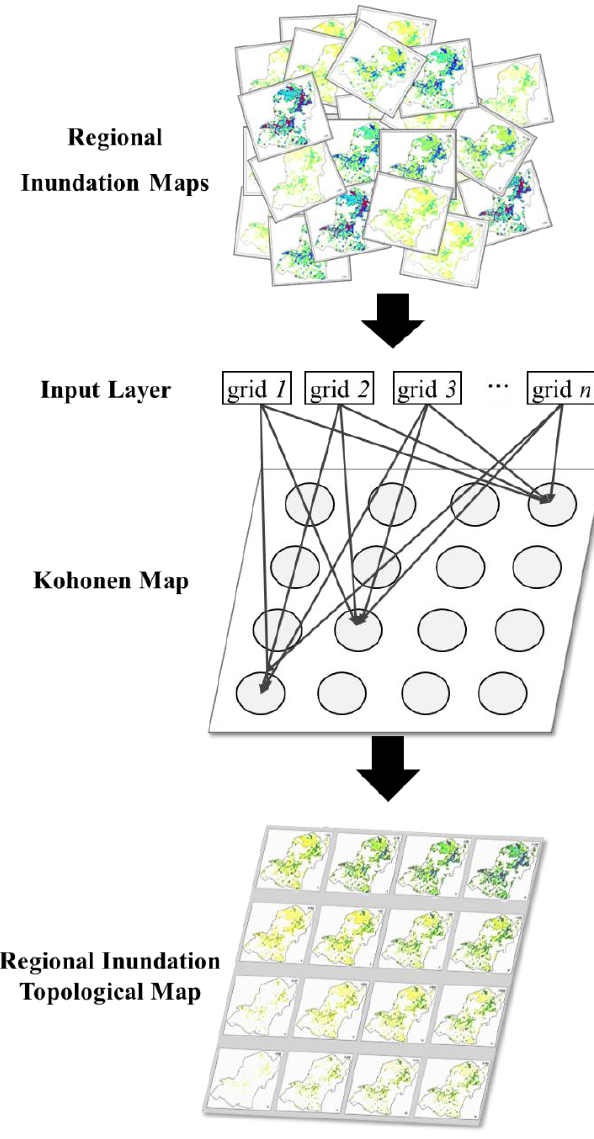
Figure 4. Cluster the spatial distributions of inundation maps by the SOM (4 × 4 neurons).